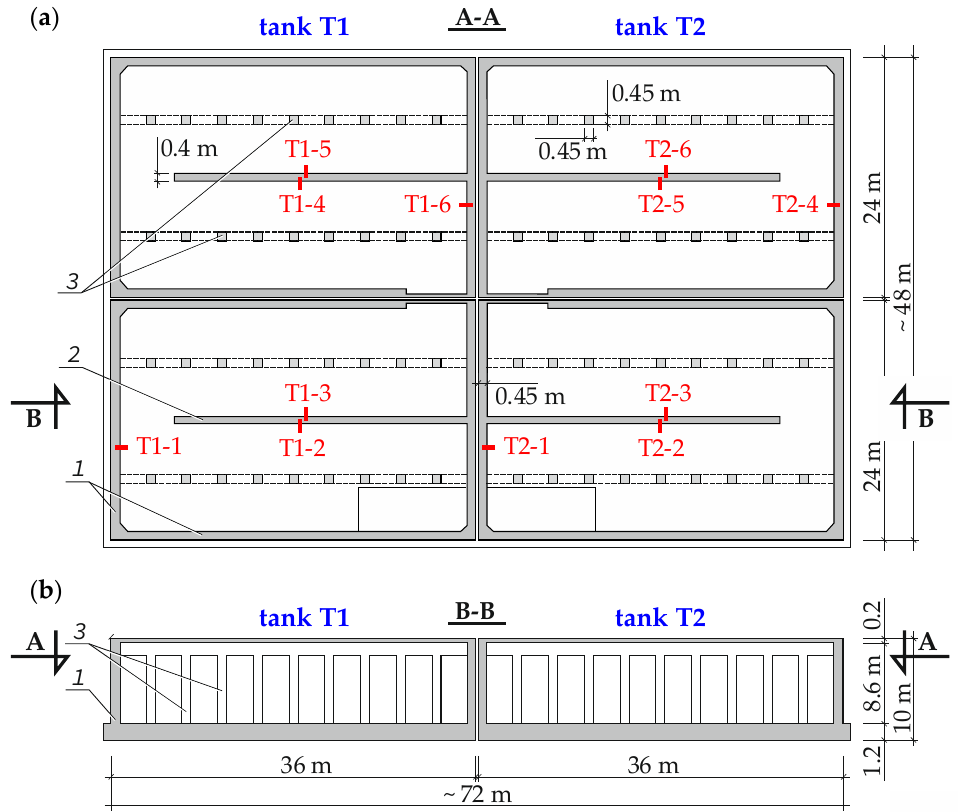
Figure 4. The tested structure of the rectangular reinforced concrete tanks for fresh water; ( a ) cross- section A-A; and ( b ) longitudinal section B-B; 1—perimeter walls, 2—internal walls, 3—columns; symbols T1-1–T1-6 and T2-1–T2-6 show places of drilling cylindrical concrete cores with embedded reinforcement for corrosion tests.